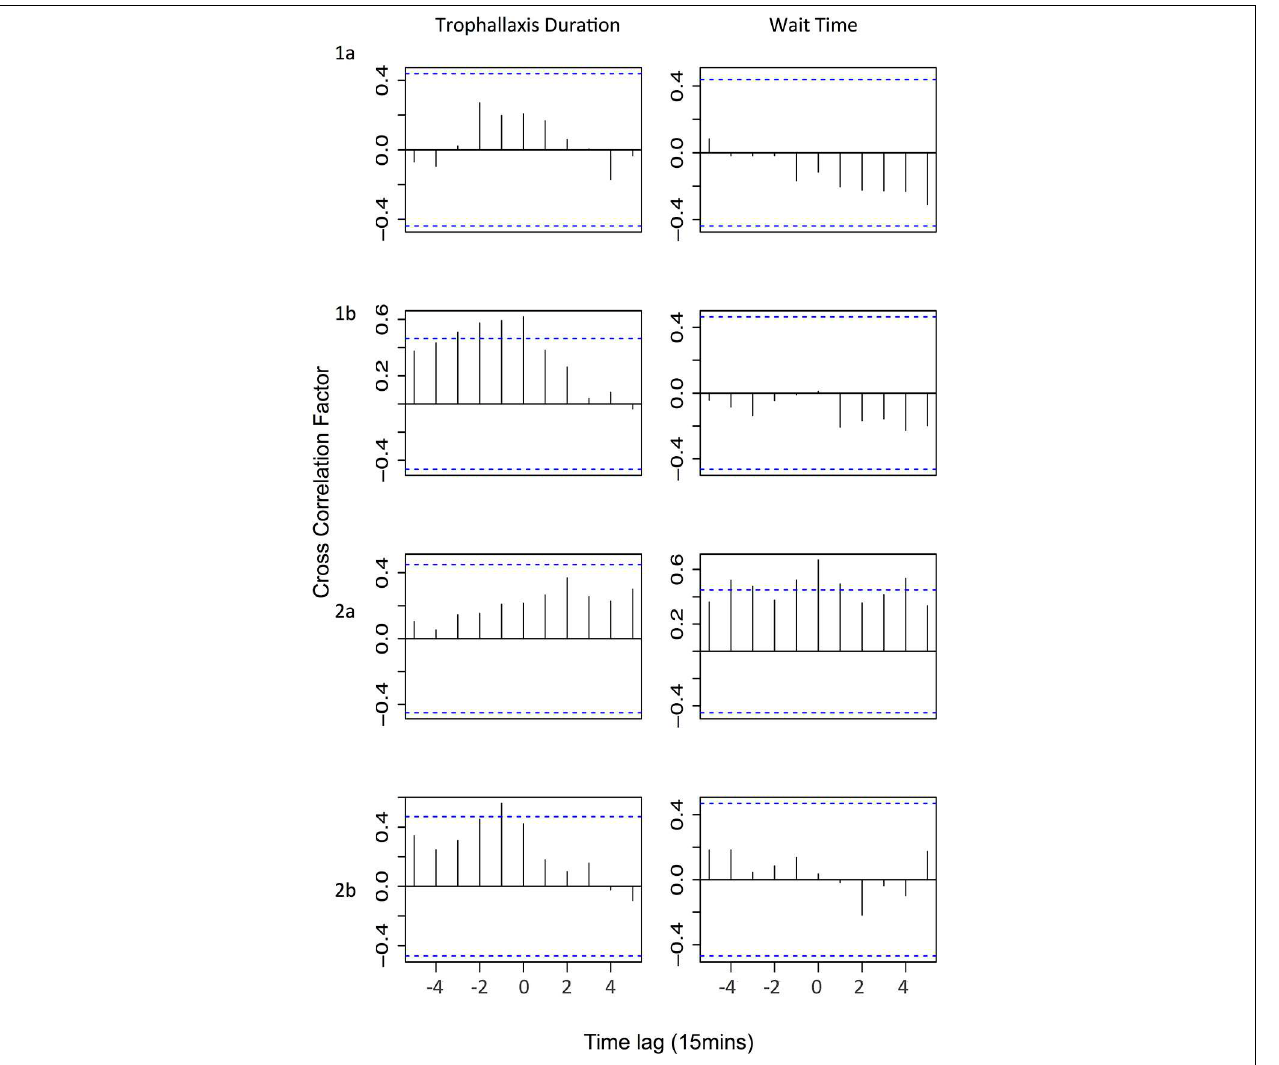
FIGURE 4 | Cross correlation test results showing correlations between either trophallaxis duration or wait time and the number of foragers leaving. Horizontal lines signify critical values corrected for multiple testing (Bonferroni correction: α = 0.0045); a correlation at any time lag